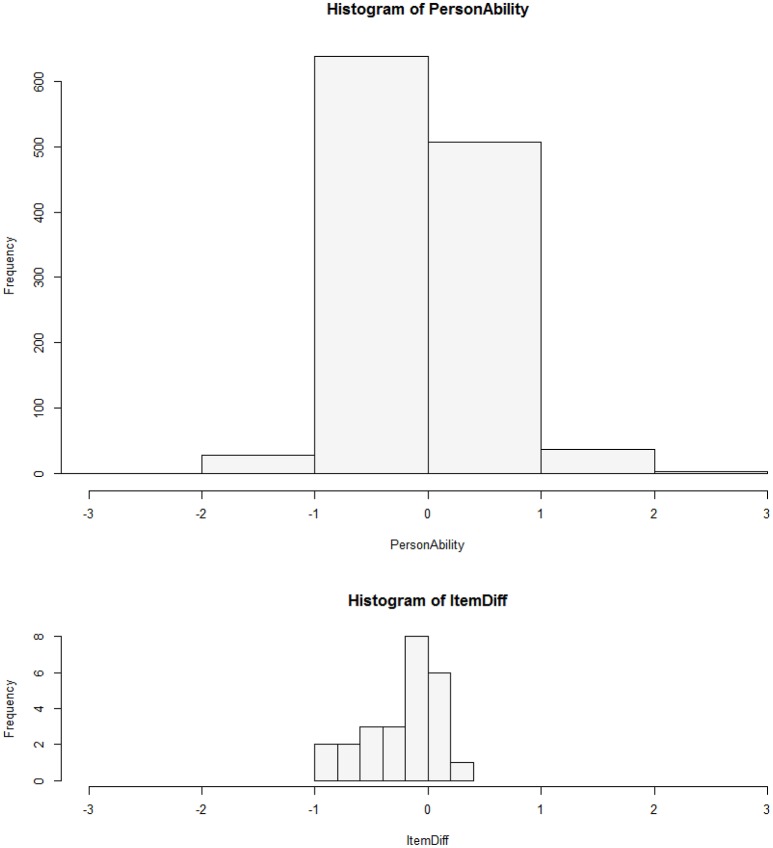
Person-item-map.